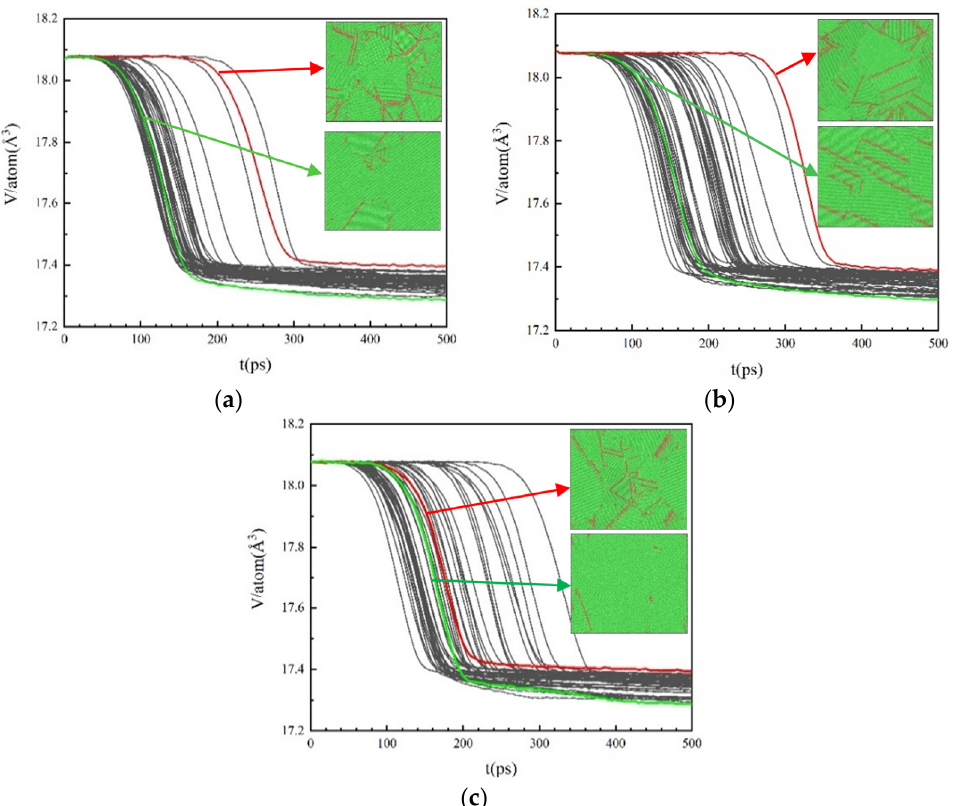
Figure 6. The evolution curves of the atomic volume during the isothermal solidification process with different cooling rates for 50 times. ( a ) 2.0 × 10 11 K/s, ( b ) 2.0 × 10 12 K/s, ( c ) 2.0 × 10 13 K/s. Figure 6 is the evolution curves of the atomic volume during the isothermal solidifi- cation process after cooling at different cooling rates for 50 times. The red and green curves represent the minimum and maximum volume changes in 50 simulations, respec- tively. The microstructures at the end of crystallization for both cases are shown in the inset of Figure 6. It can be found that when the volume change is small, the proportion of HCP atoms in the system is high, and the grains with different orientations are more. In the case of a large volume change, the proportion of HCP atoms is low, and the grain orientation is relatively similar. Substituting 𝑓 (cid:3023) (𝑡) calculated from Equation (3) in both cases into Equation (2), the relationship between 𝑙𝑛𝑙𝑛(1 (1 − 𝑓 (cid:3049) )⁄ ) and ln(𝑡) is obtained, as shown in Figure 7. The blue curve represents the case with a large volume change, and the red curve represents the case with a small volume change. The slope of the curve is the Avrami exponent 𝜂 , which is indicated in the figure. In Figure 7, the whole process can be divided into three stages. The first stage is too dispersive and, thus, not fitted. In the second stage, 𝜂 be- comes larger, with the main growth stage of grains, and 𝜂 is between ~4 and ~15, indicat- ing that nucleation and growth processes are a three-dimensional growth mode [26]. In the subsequent third stage, growth becomes slow again, mainly due to the depletion of the parent phase during growth [36].